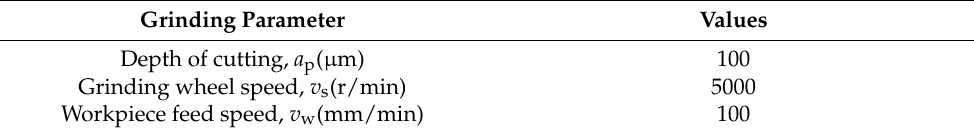
Table 2. Grinding parameters.